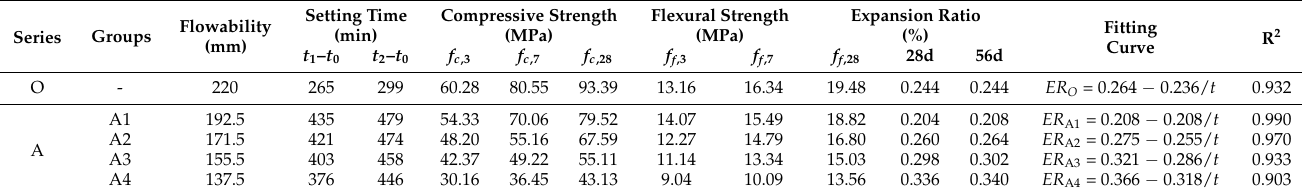
Table 3. Fresh and hardened properties of MOC pastes with and without